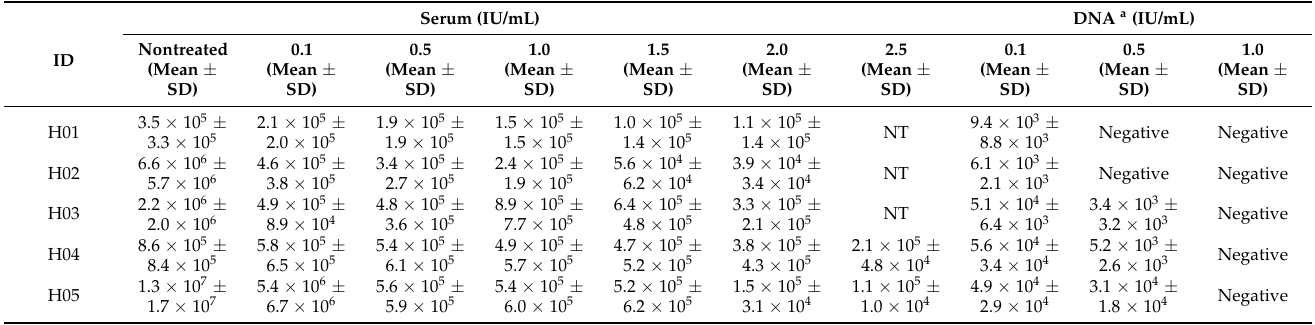
Table 1. Optimization of Benzonase ® concentration among human serum samples.